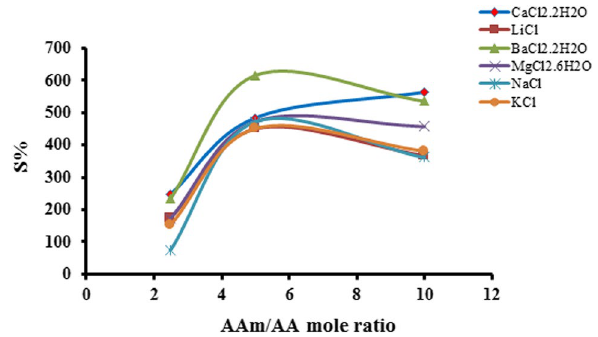
Fig. 6 Swelling changes in samples including 4 mol% percentage of MBA (1, 5, and 9) versus AAm/AA mole ratio at the swelling time of 180 min